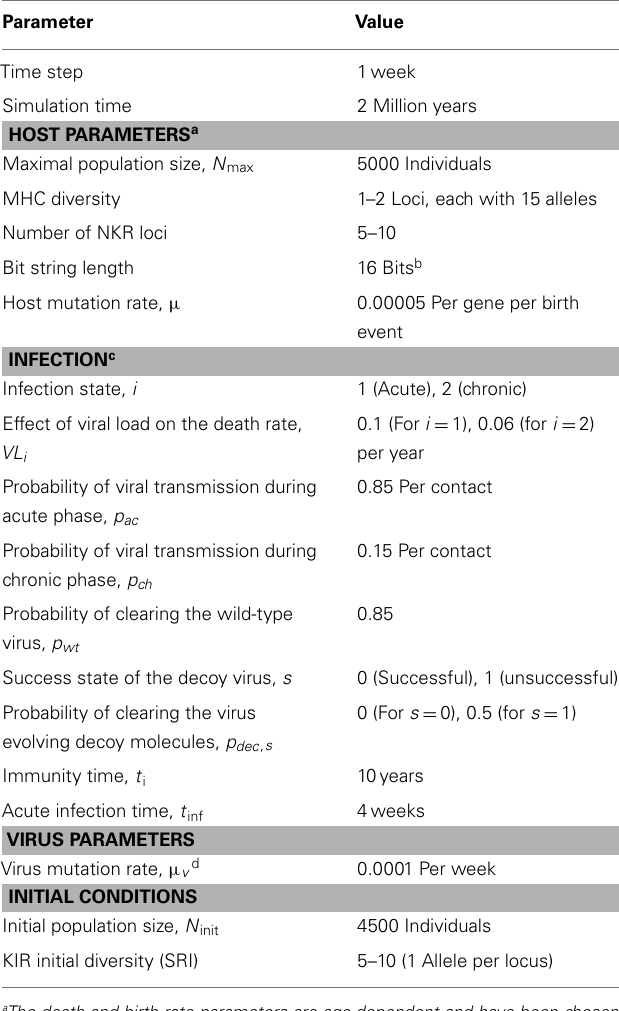
Table 1 | Parameters of the agent-based